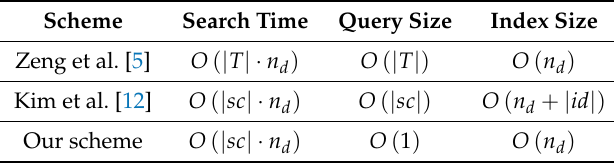
Table 1. Efficiency comparison of public key encryption with keyword search (PEKS) schemes. ( | sc | refers to the value of search counter, n d refers to the number of data, | id | refers to size of